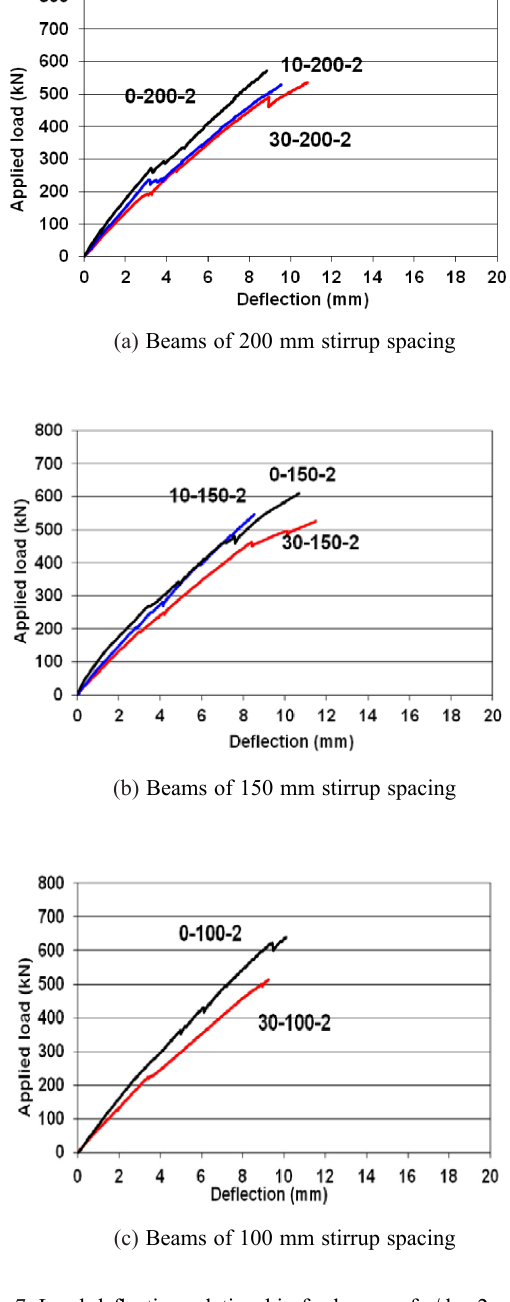
Fig. 7. Load-deflection relationship for beams of a/d =